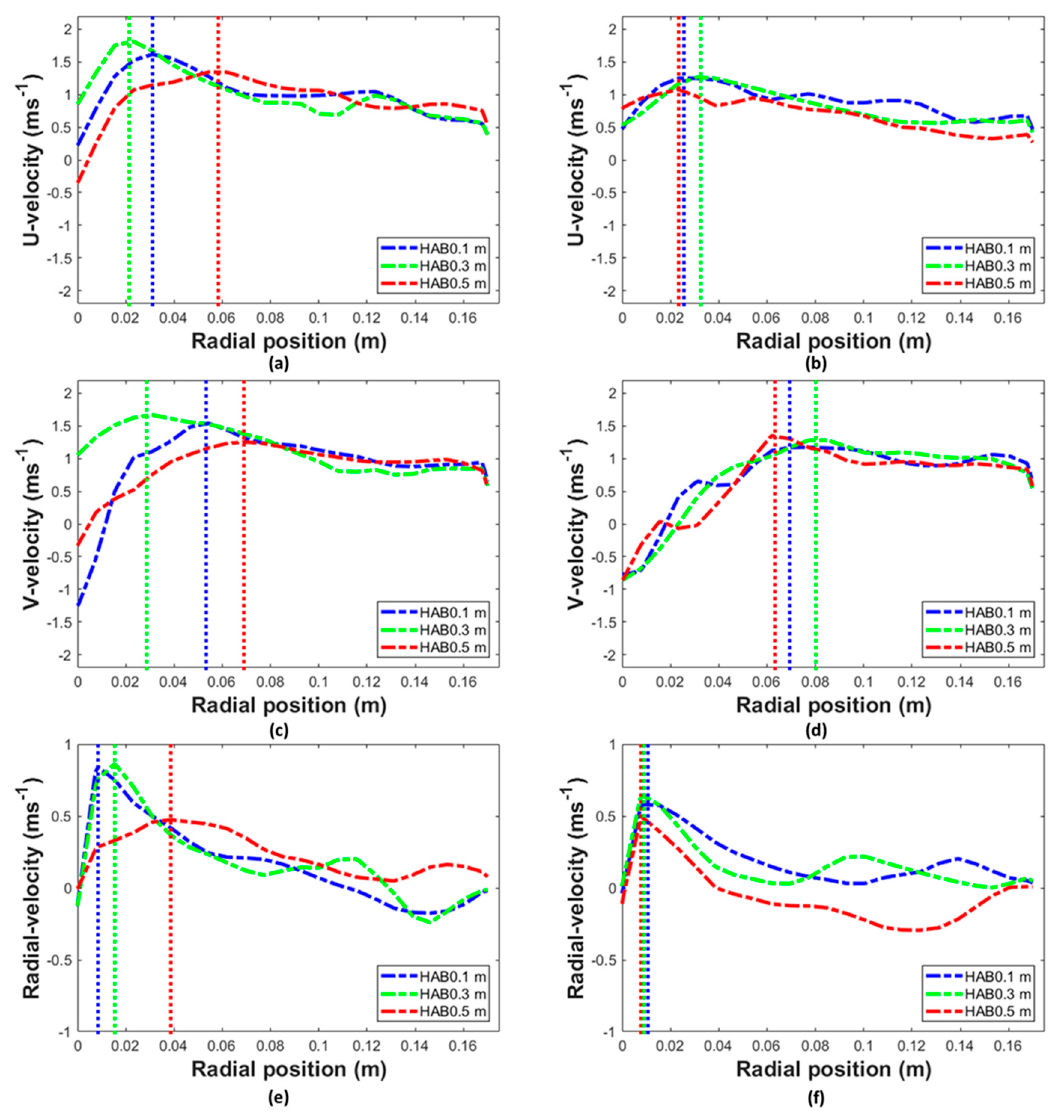
Figure 15. Plot of U, V and radial velocity along with the radial direction at three monitoring HABs: U-velocity of the 01 slit case ( a ), U-velocity of the 02 slit case ( b ), V-velocity of the 01 slit case ( c ), V-velocity of the 02 slit case ( d ), radial velocity of the 01 slit case ( e ), radial velocity of the 02 slit case ( f ). Circulation is indeed the unique feature distinguishing fire whirls from non-swirling